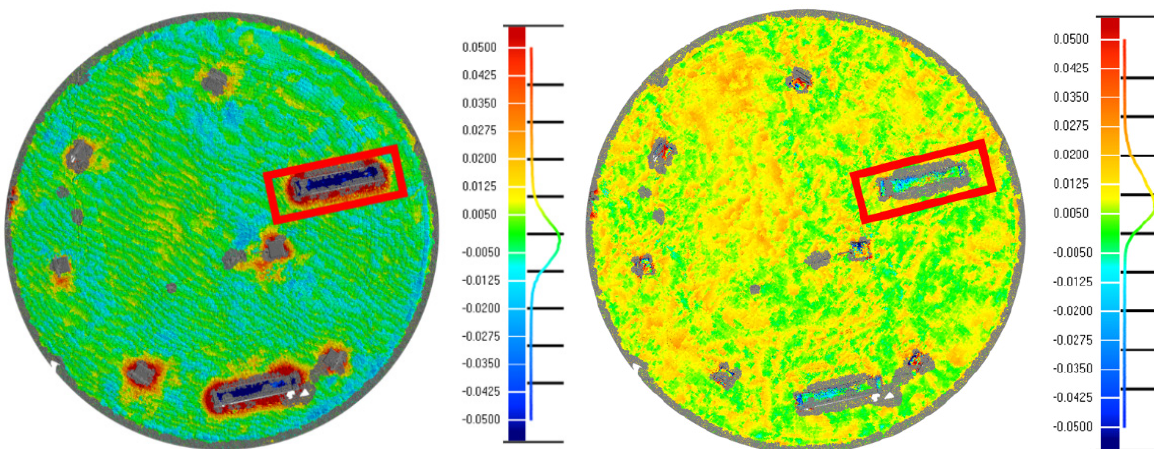
Figure 14. Colour representation of the area-based vertical deviations [m] for the paving stones: PS TIF (left) and Pix4D TIF (right). Deviations in green ±